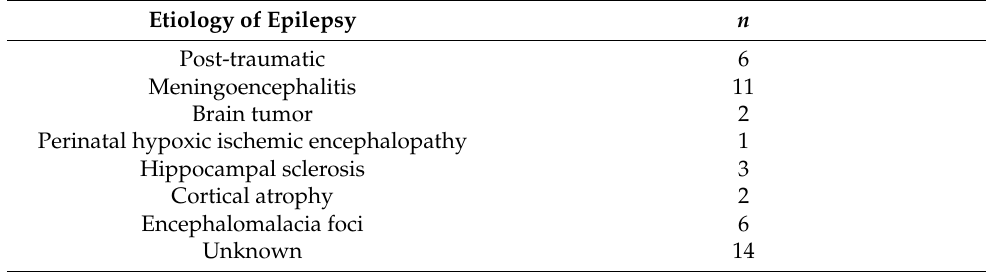
Table 2. Epilepsy etiology details of all VNS implanted patients. Etiology of Epilepsy